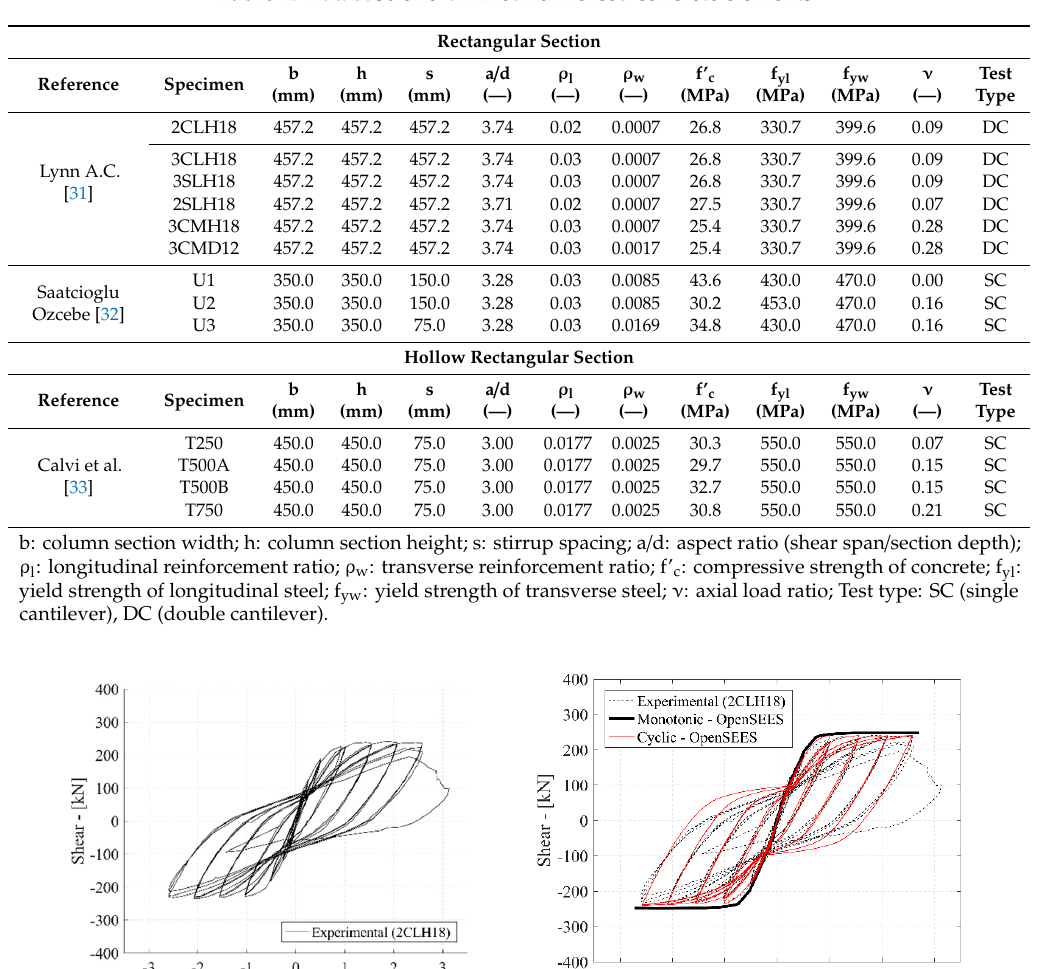
Table 1. Database of examined reinforced concrete elements.